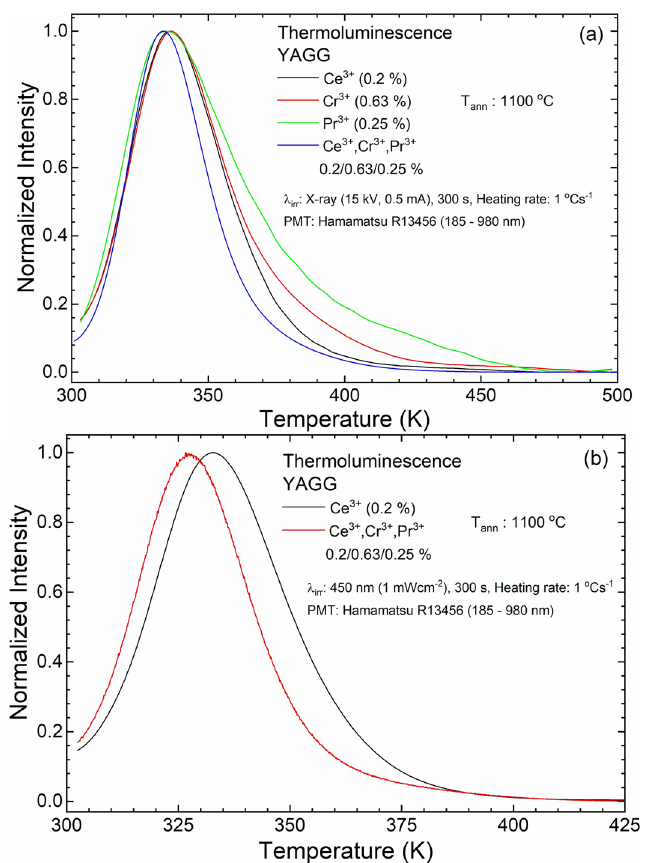
Figure 9. Normalized TL glow curve of singly and triply doped YAGG nanophosphors annealed at 1100 °C. ( a )